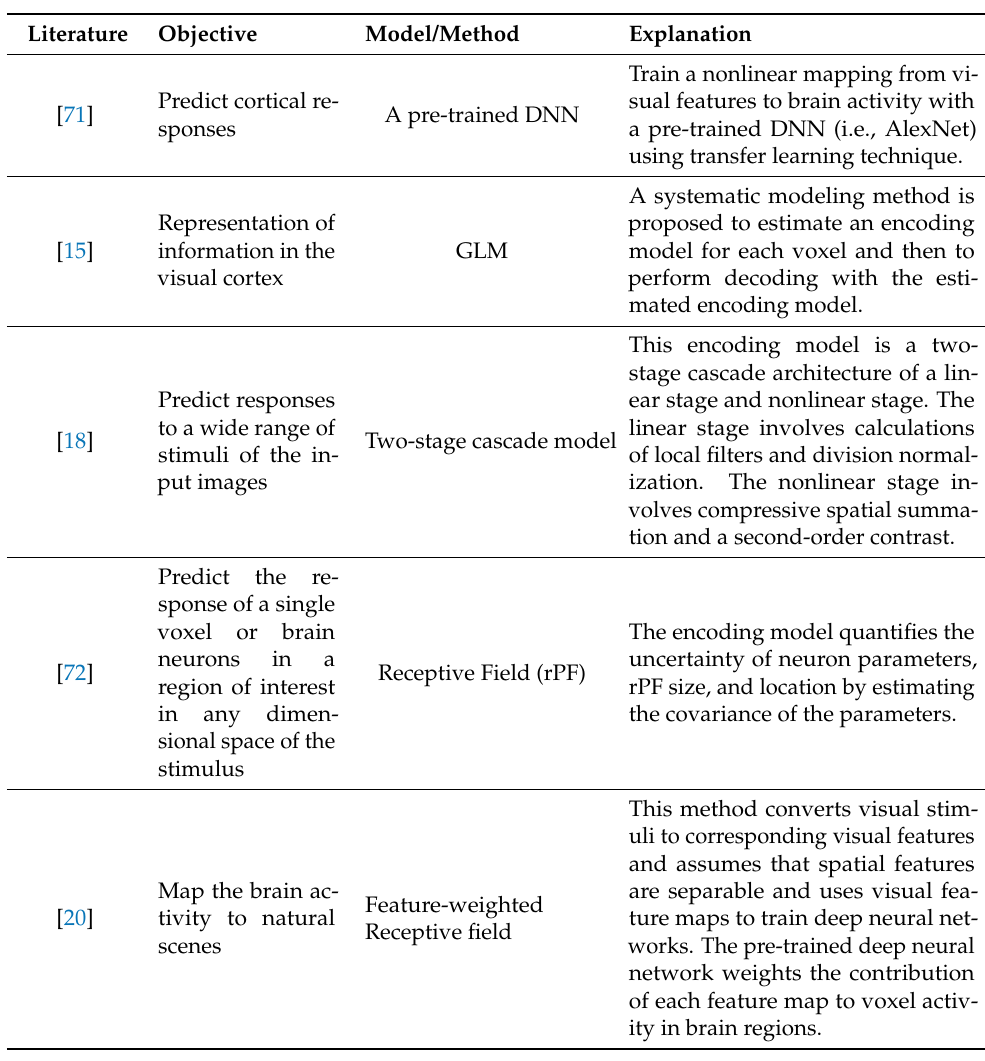
Table 1. Brain encoding